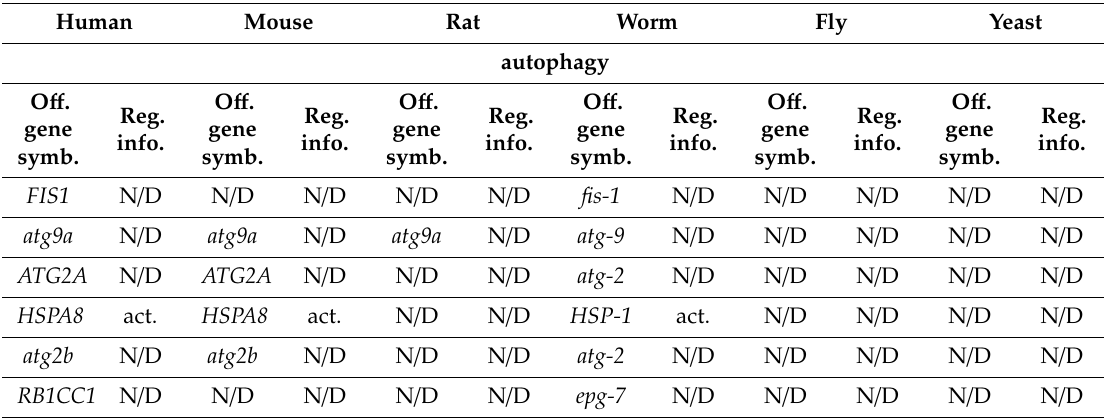
Table 4. Selected list of HSF1 target genes conserved between vertebrate and non-vertebrate species, identified by using